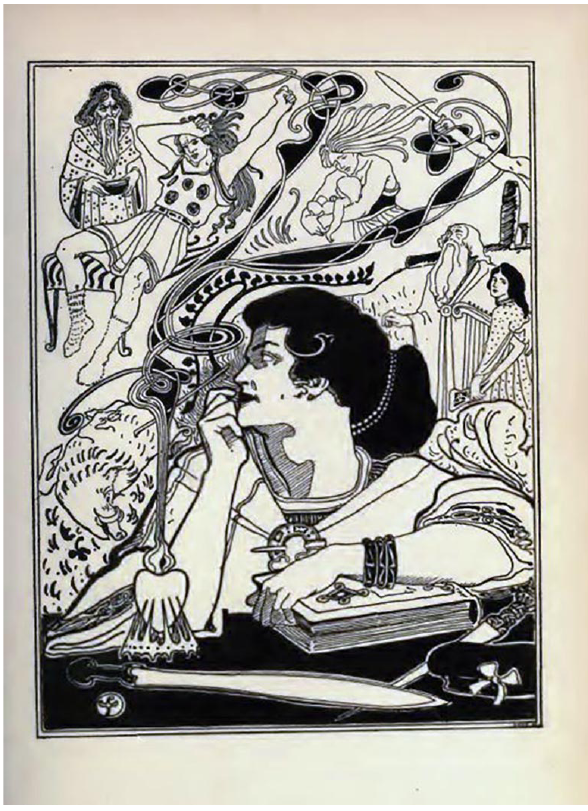
Fig. 3 John Duncan, ‘Anima Celtica’, Evergreen: A Northern Seasonal (Spring 1895), p. 107, private collection.